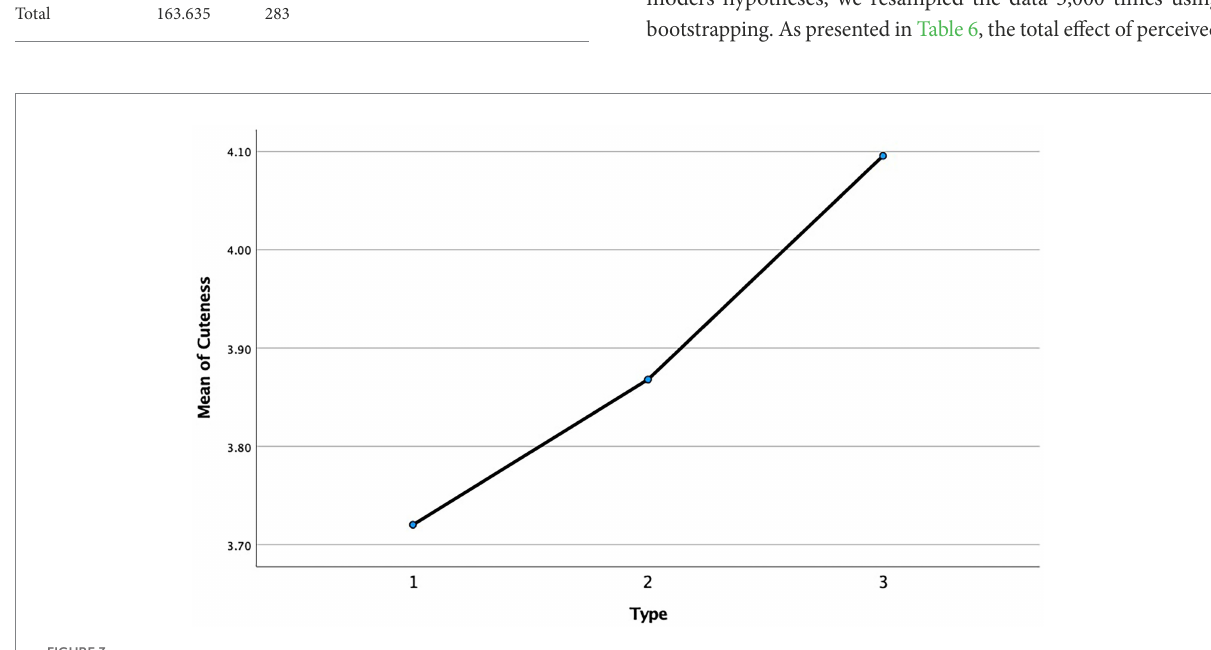
FIGURE 3 Mean plot.